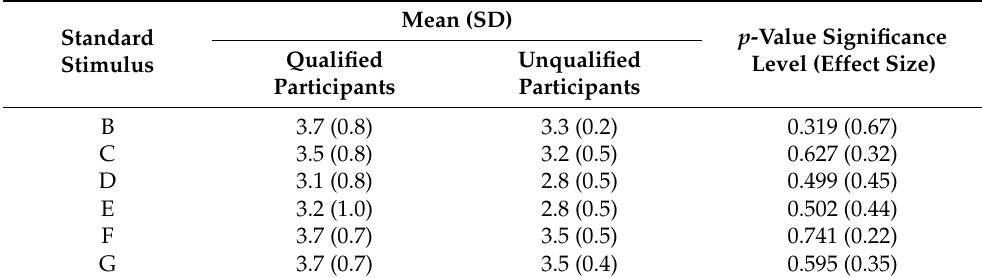
Table 3. t -test and Mann–Whitney U test with a significance level of 5% to confirm the differences between teachers’ and beginning learners’ correct answer rate .